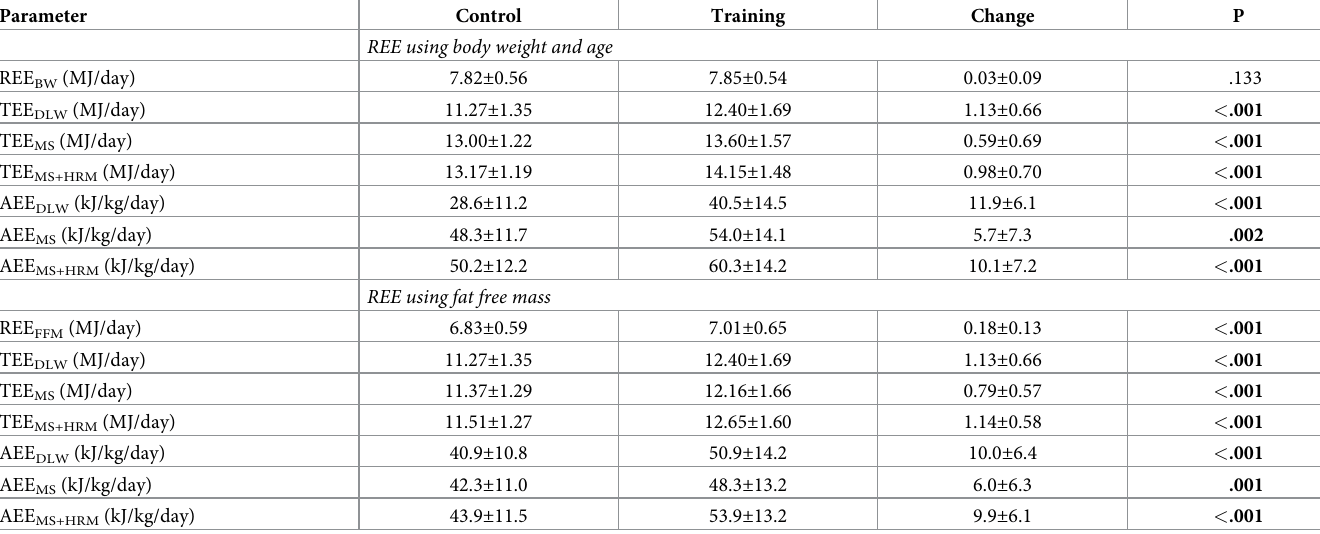
Table 4. Training-induced change in daily energy expenditure (Mean ± SD); comparison between control and training periods (n = 13).